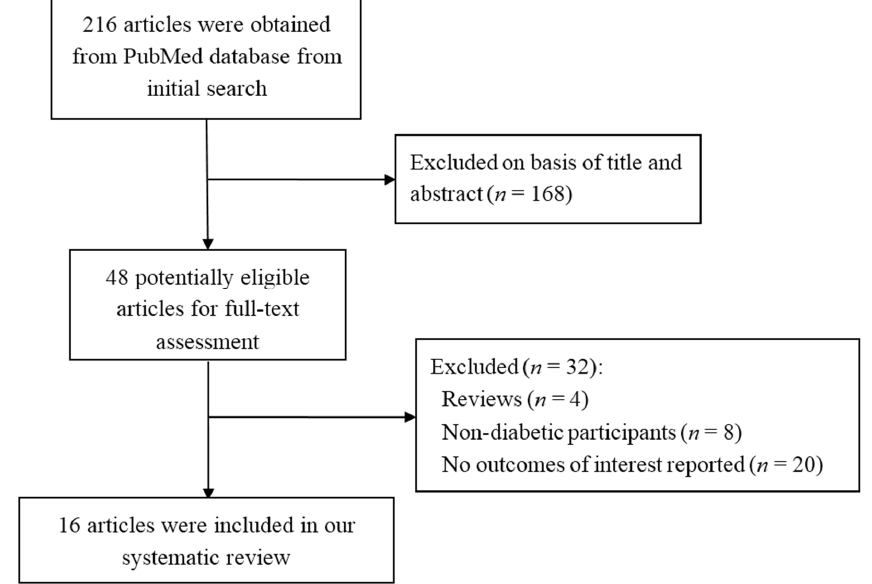
Figure 1. Flow diagram for study identification.